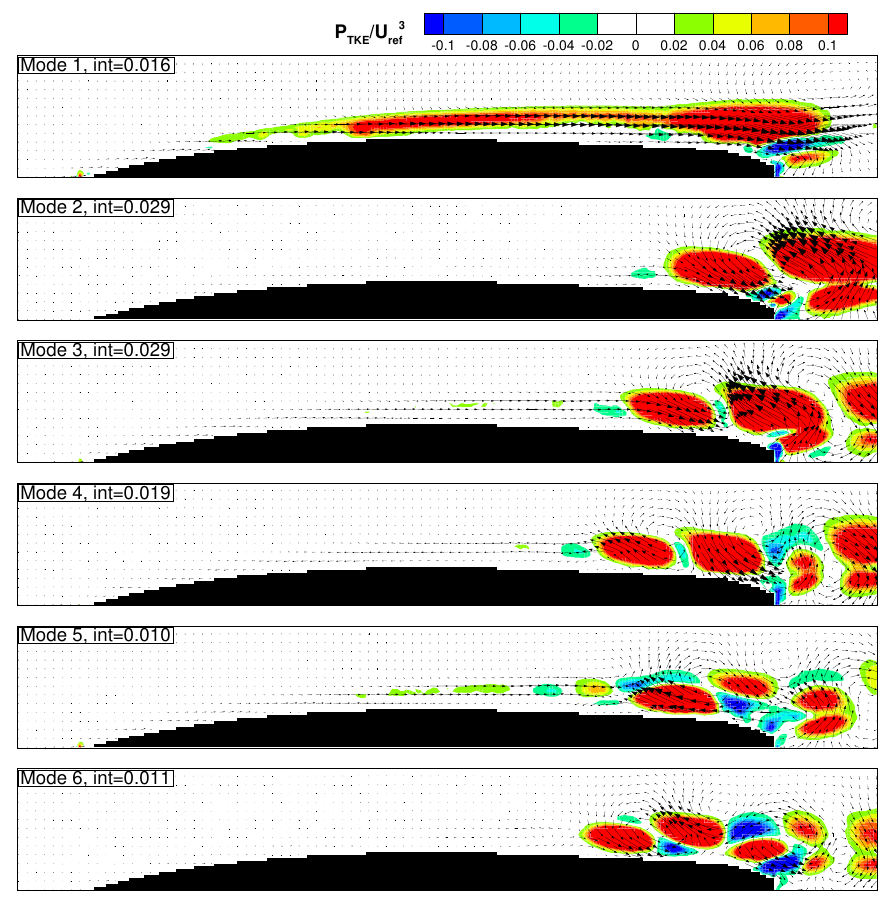
Figure 8. Turbulence kinetic energy production rate per POD mode, steady